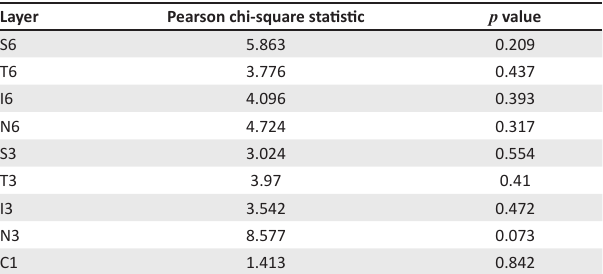
FIGURE 3: Correlation between central subfield thickness (C1) ( µ m) on SD-OCT and cumulative dosage (g). TABLE 2: Comparisons of all retinal thickness layers as per the macula map with the chi-square statistic between Group A (< 5 years on chloroquine) and Group B (> 5 years on chloroquine) ( df =